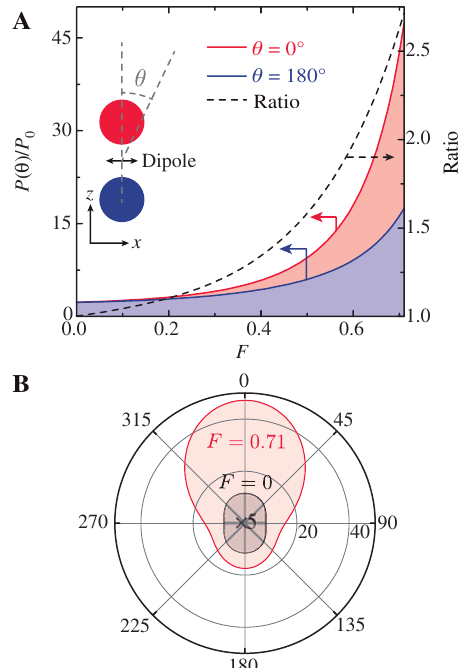
Figure 3: Analysis of the directionality of the power radiated. (A) Power radiated by the dimer along its axis in the direction of the gain side, θ = 0 ° (red solid curve), and the loss side, θ = 180 ° (blue solid curve), normalised to P (left axis). This quantity is plotted as a 0 = −0.19 γ function of the pumping parameter F for a detuning ω − ω . 0 0 The black dashed curve (right axis) shows the ratio between the power radiated along the two aforementioned directions. (B) Angular distribution of the power radiated by the system for F = 0.71 (red curve) compared with that of the passive dimer, F = 0 (black curve). Note that the latter is multiplied by 5 to improve the visibility. 0